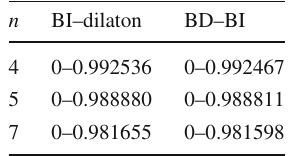
Table 1 Allowed range of α for the efficiency in Figs. 14 and